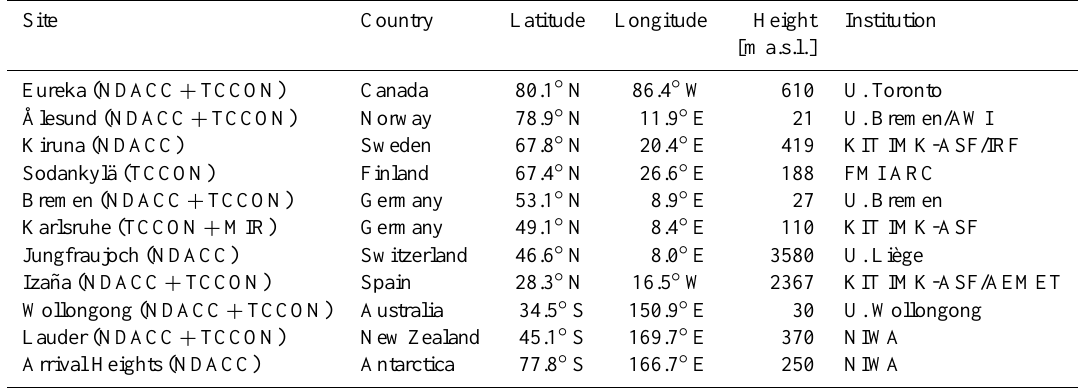
Table 4. Overview of collaborating ground-based NDACC/TCCON FTIR stations.